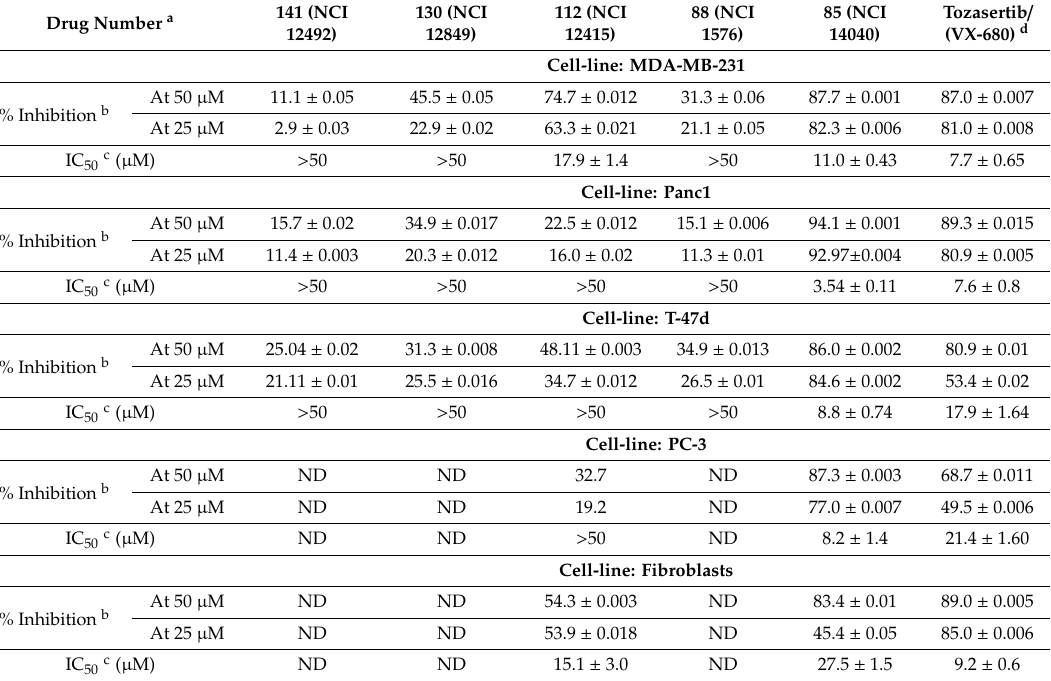
Table 6. The concentrations of the five active hits that prevented cell growth by 50% or (IC50) values and their anti-Aurora-A kinase inhibition % at 50 µ M and 25 µ M after 72 h against di ff erent cancer cell lines compared to the Aurora-A kinase standard inhibitor